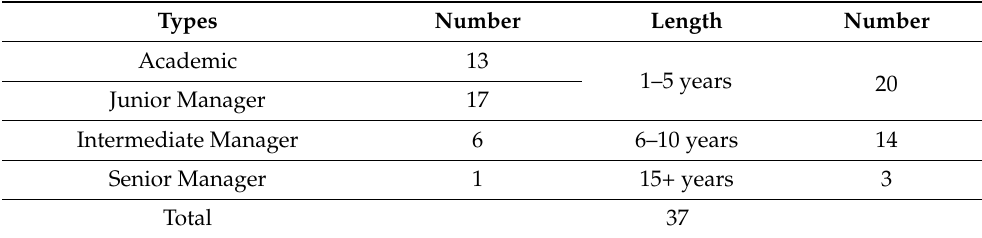
Table 2. Types and lengths of the occupations of